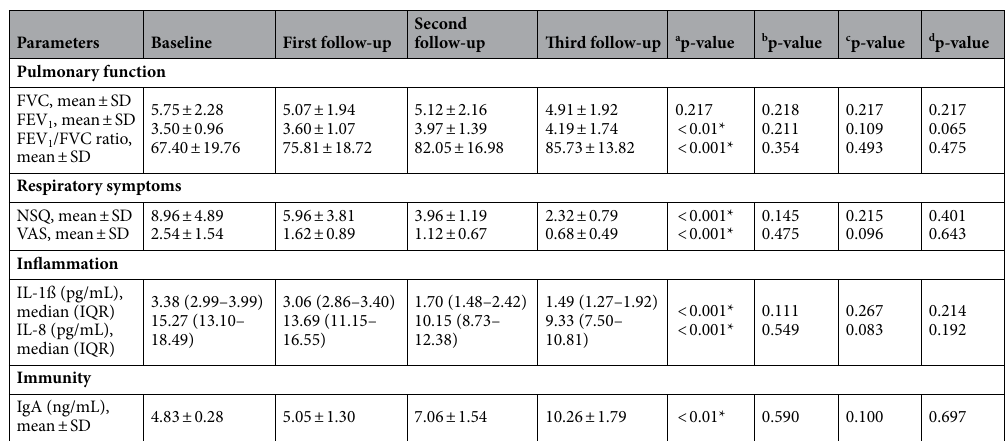
73.2% respectively. The underlying mechanism responsible for such changes was likely due to the dropped in IL-1ß and IL-8 level, with 54.9% and 40.8% reduction respectively in this study. IL-1ß and IL-8 are both the major cytokines involved in the initiation and persistence of inflammation in airway and lung 28,29 . IL-1ß is an inducible cytokine and generally only expressed in damaged cells or triggered by pathogen product through the activation of pattern recognition receptors (PRRs) 30 . In the lung, IL-1β is produced by epithelial cells, alveolar